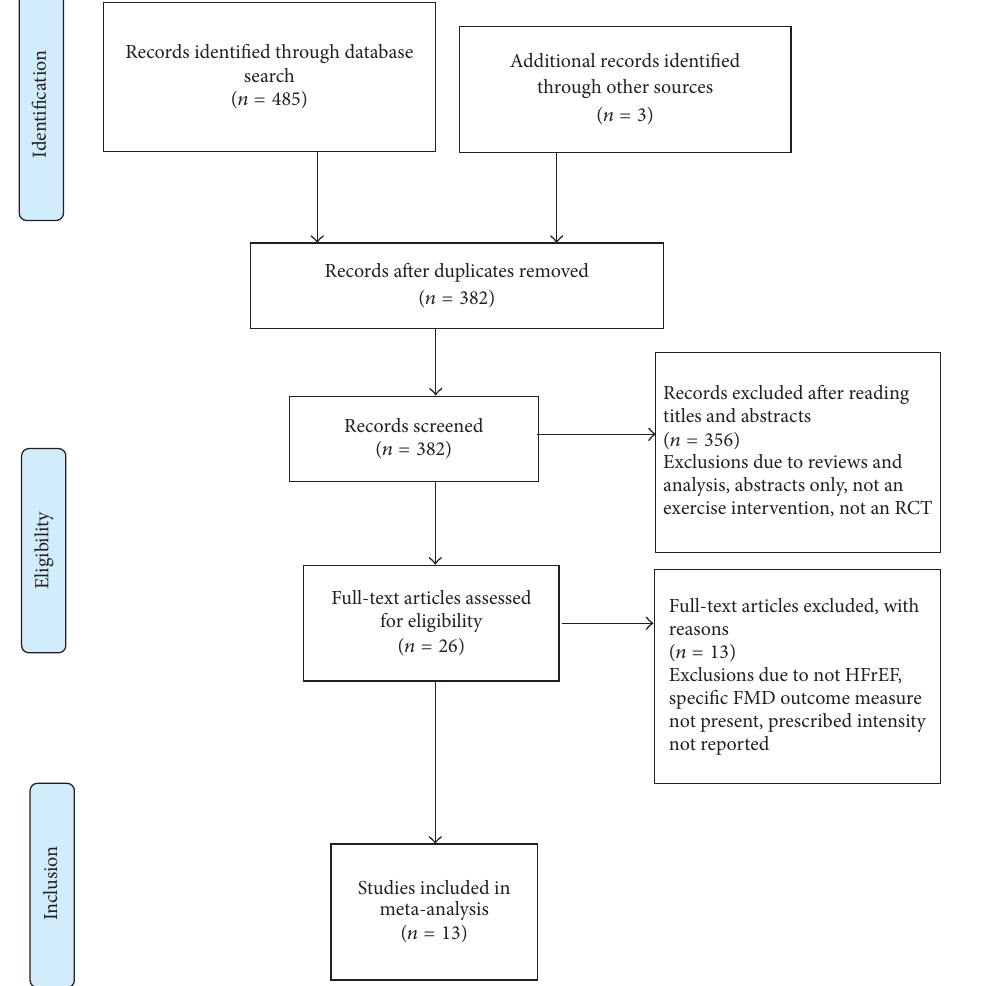
Figure 1: PRISMA flow